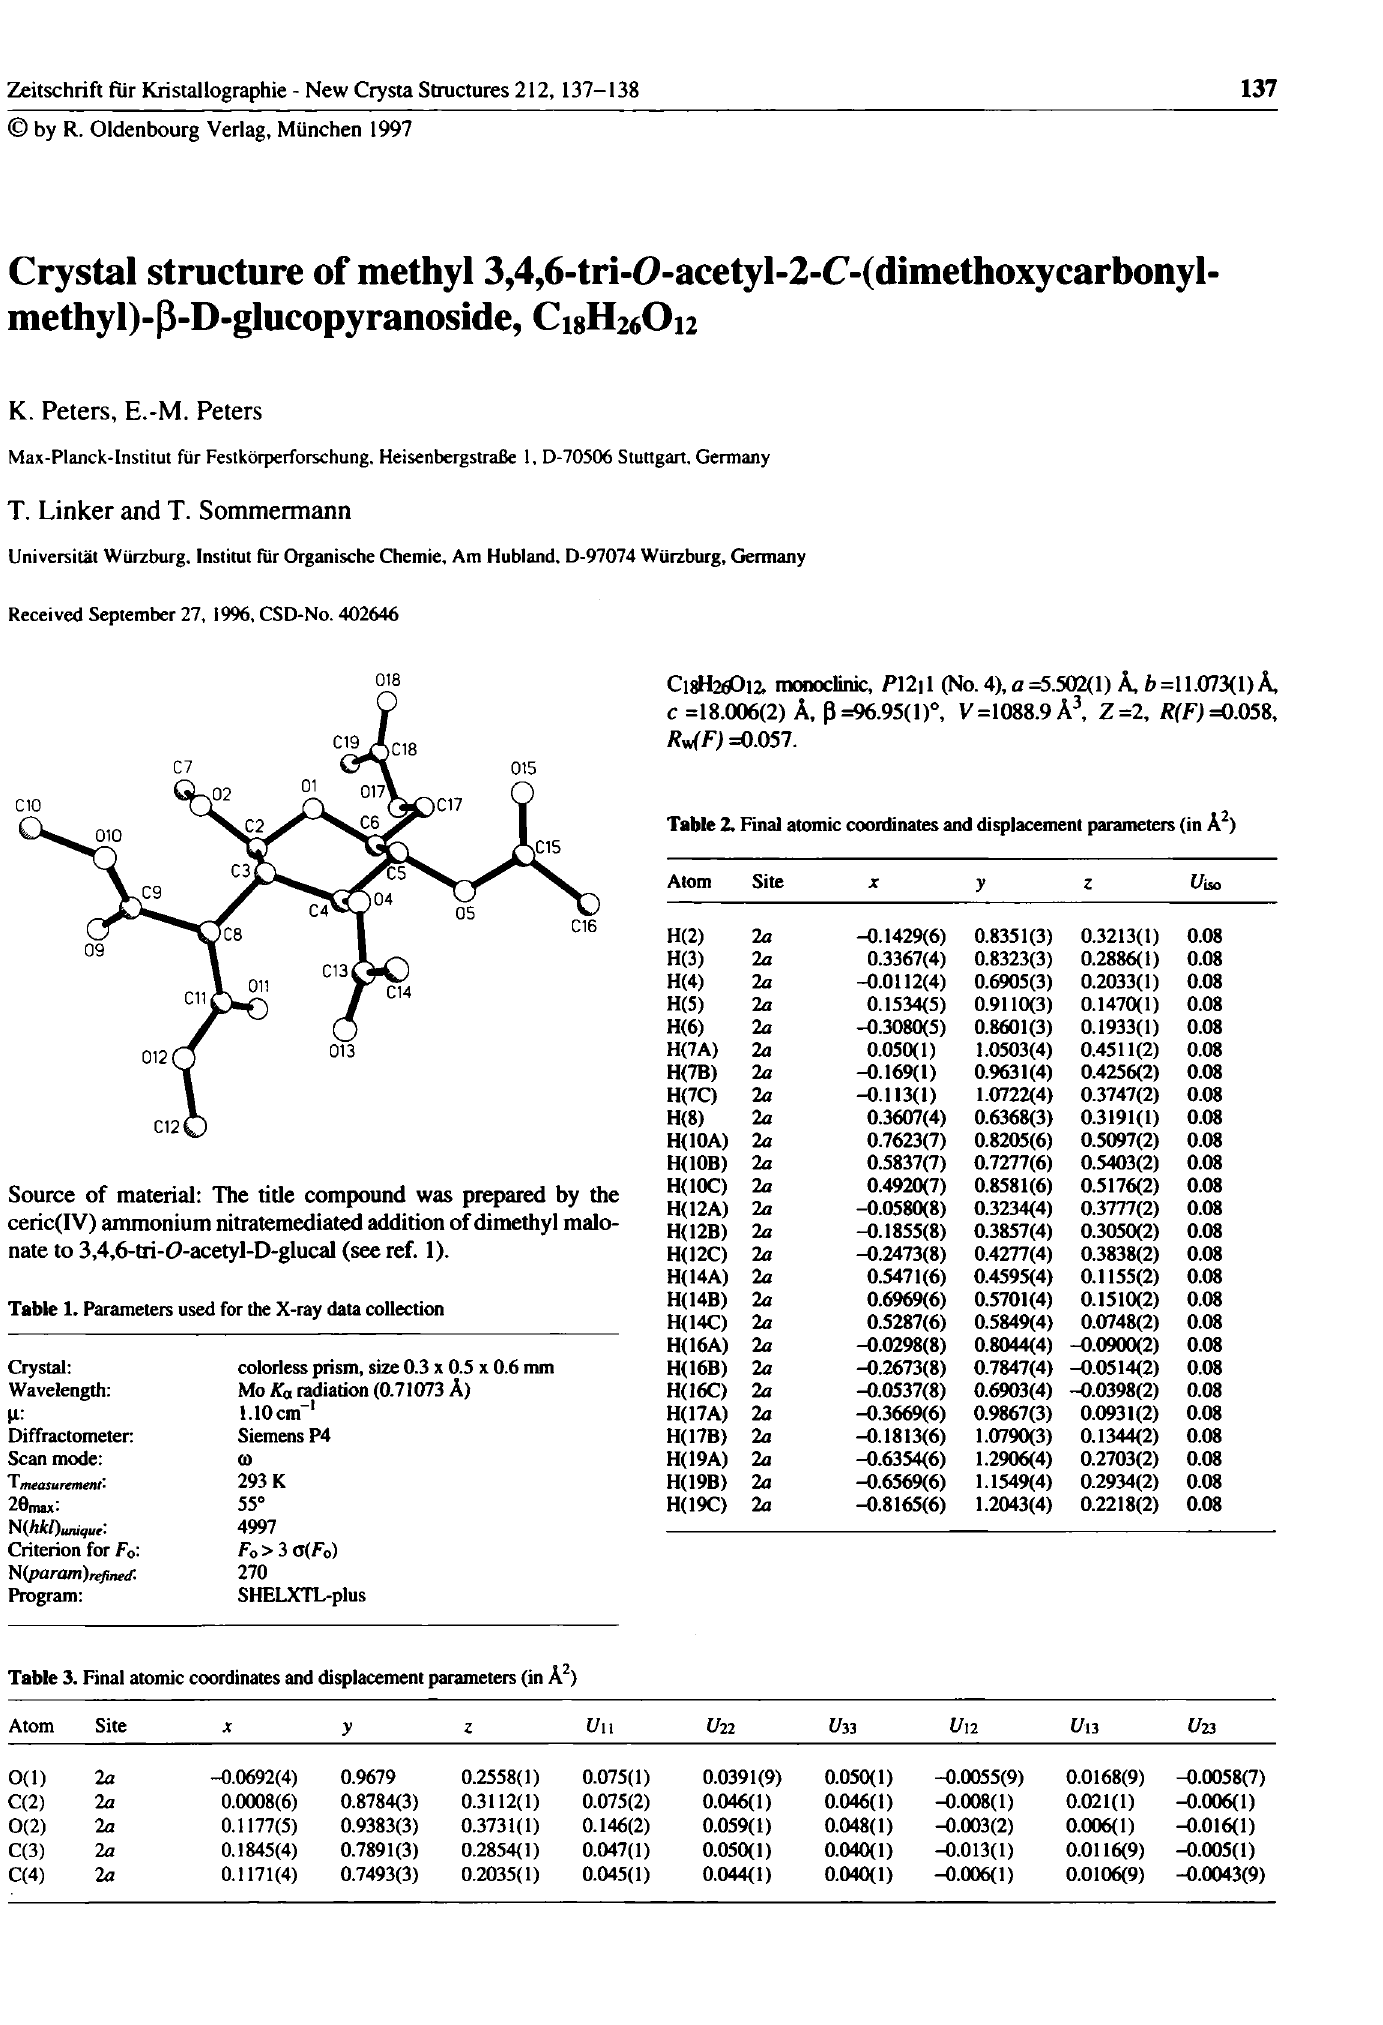
Table 3. Final atomic coordinates and displacement parameters (in Â 2 ) Atom